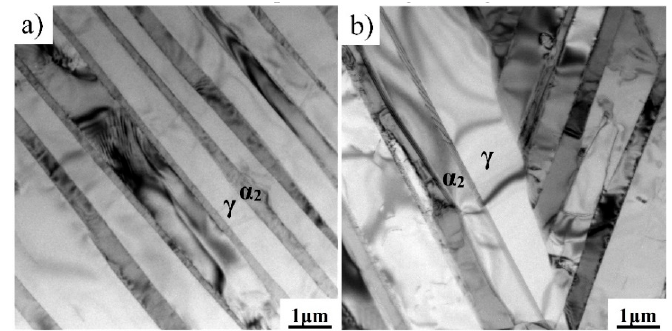
Figure 3. TEM images showing the microstructures of the as-forged Ti–43Al–2Cr–2Mn–0.2Y alloy after heat treatment at 1320 °C/10 min: ( a ) colony boundaries and ( b ) triple junctions.